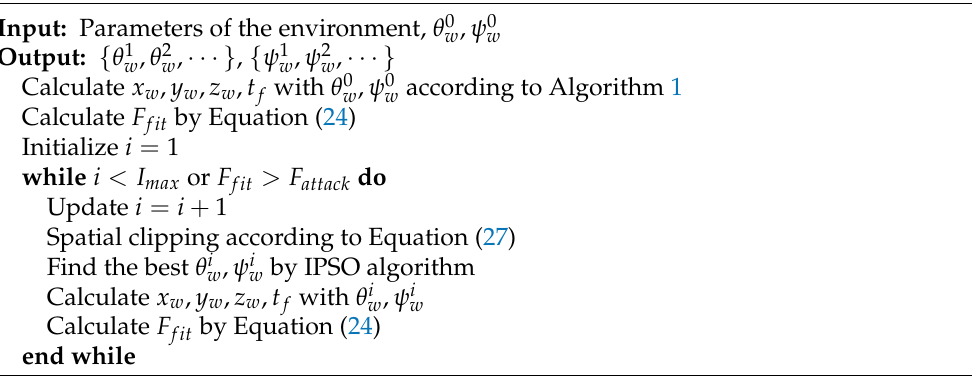
Algorithm 2 Expert demonstrations generation algorithm